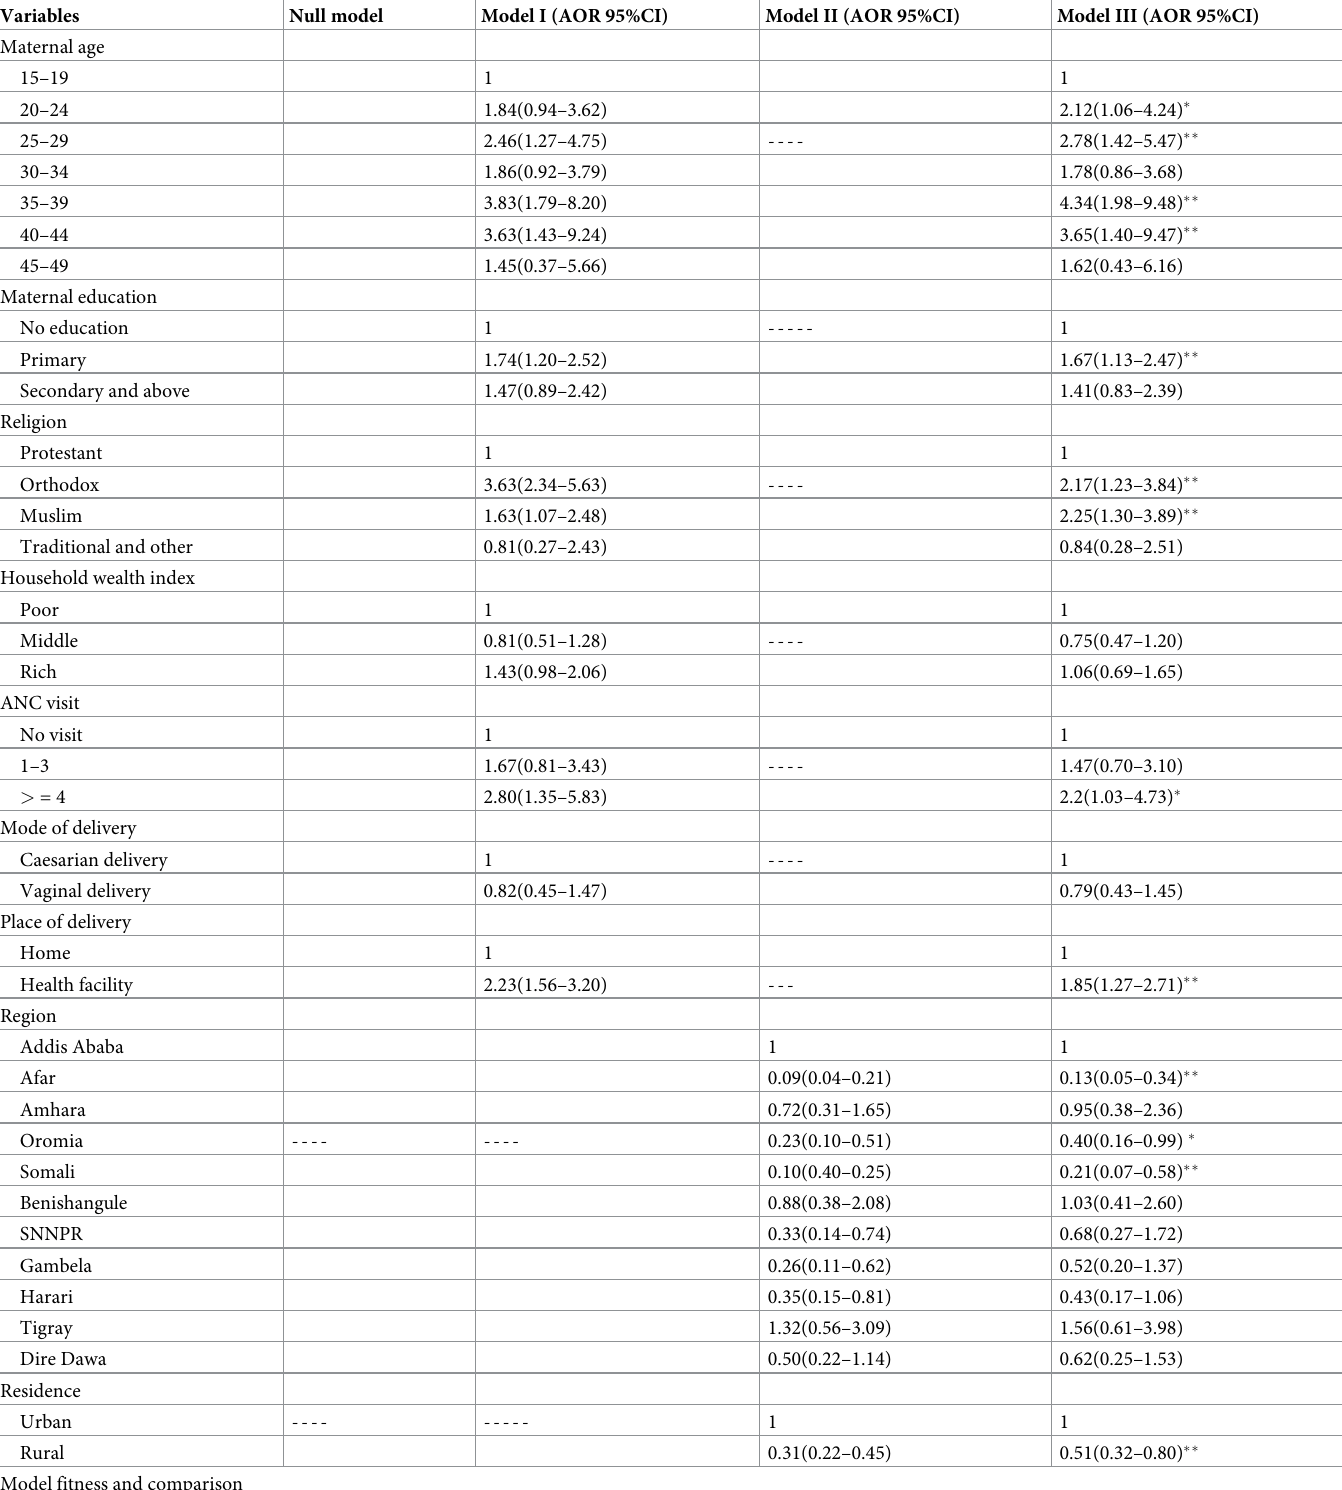
Table 4. Multivariable multilevel analysis of complete basic childhood vaccination among children aged 12–23